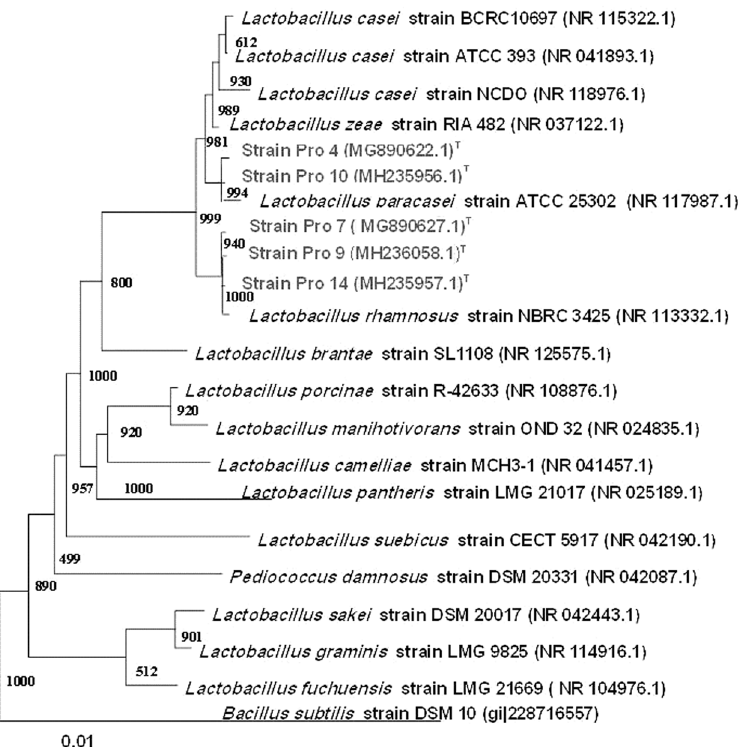
Figure 1. Neighbor-joining tree showing the estimated phylogenetic relationships of the probiotic strains P4 and P7 (shown in gray) and other closely-related strains of the genus Lactobacillus . Bootstrap values out of 1000 are given at the nodes. Bacillus subtilis strain DSM 10 (gi|228716557) as out group.